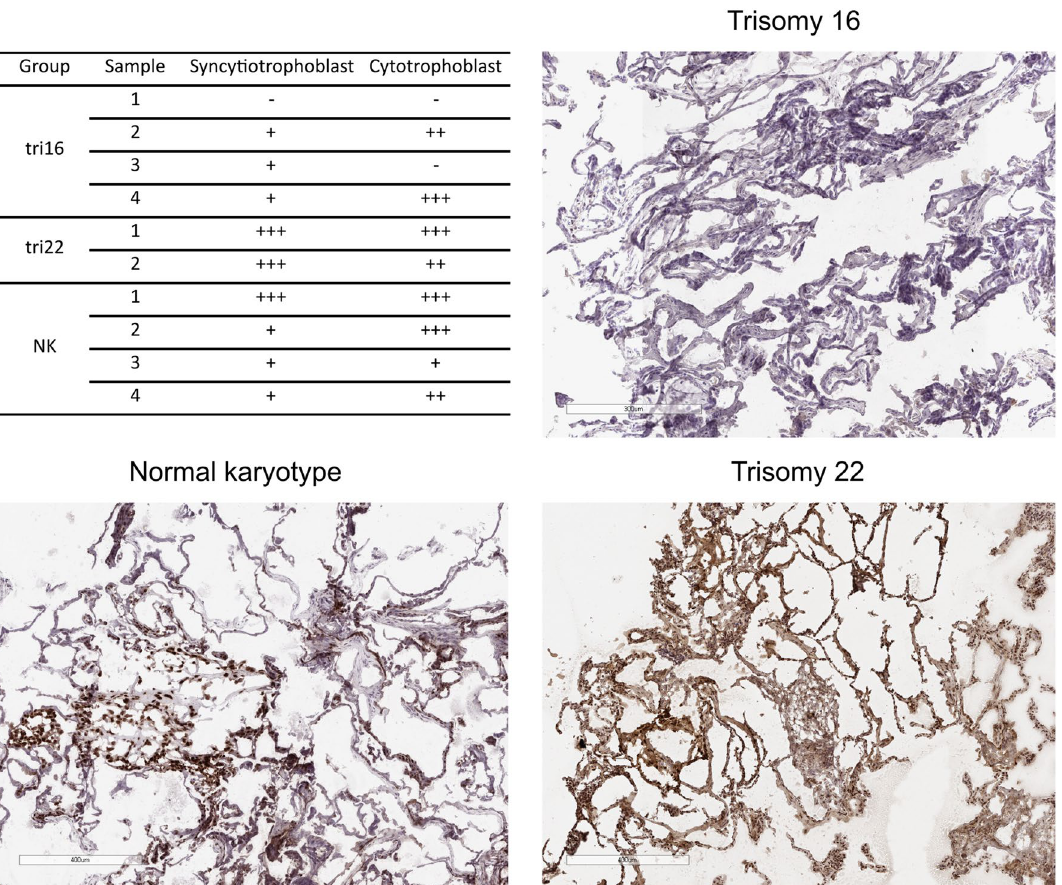
Figure 5. Examples of GATA3 protein staining in frozen sections of syncytiotrophoblast and cytotrophoblast cells of miscarriages with trisomy 16 (n = 4), trisomy 22 (n = 2), and a normal karyotype (n = 4).